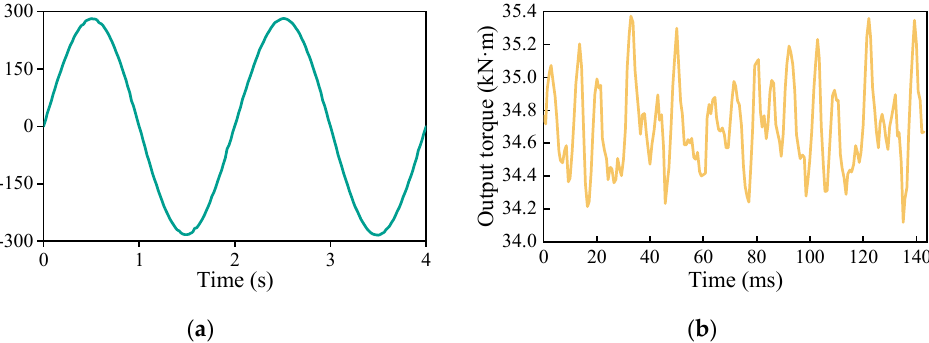
Figure 5. Cogging torque and output torque under rated load: ( a ) cogging torque; ( b ) output torque.